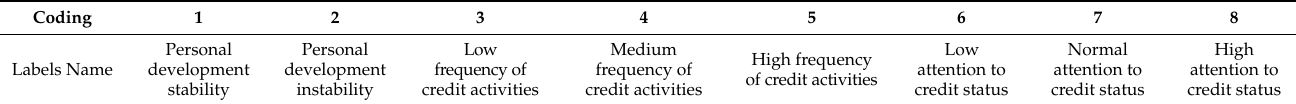
Table 7. Label information conversion process record.